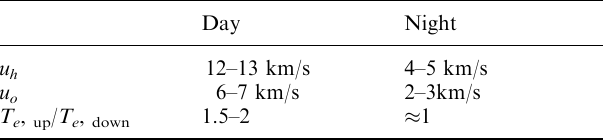
Table 1. A summary of the polar wind day-night asymmetries observed by the Akebono satelite. The average ion outflow velocities were measured between 5000 and 9000 km altitude, and the electron temperature ratios were obtained at about 1700 km